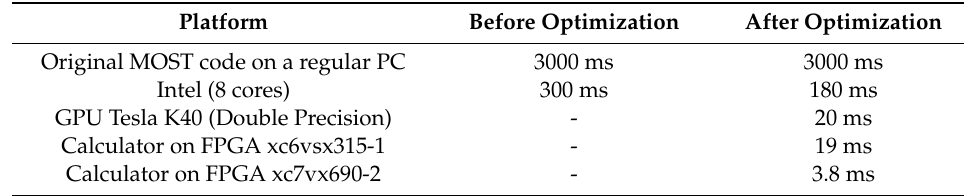
Table 1. Comparison of performance calculating tsunami wave propagation on different hardware platforms (reduced version from [14]).